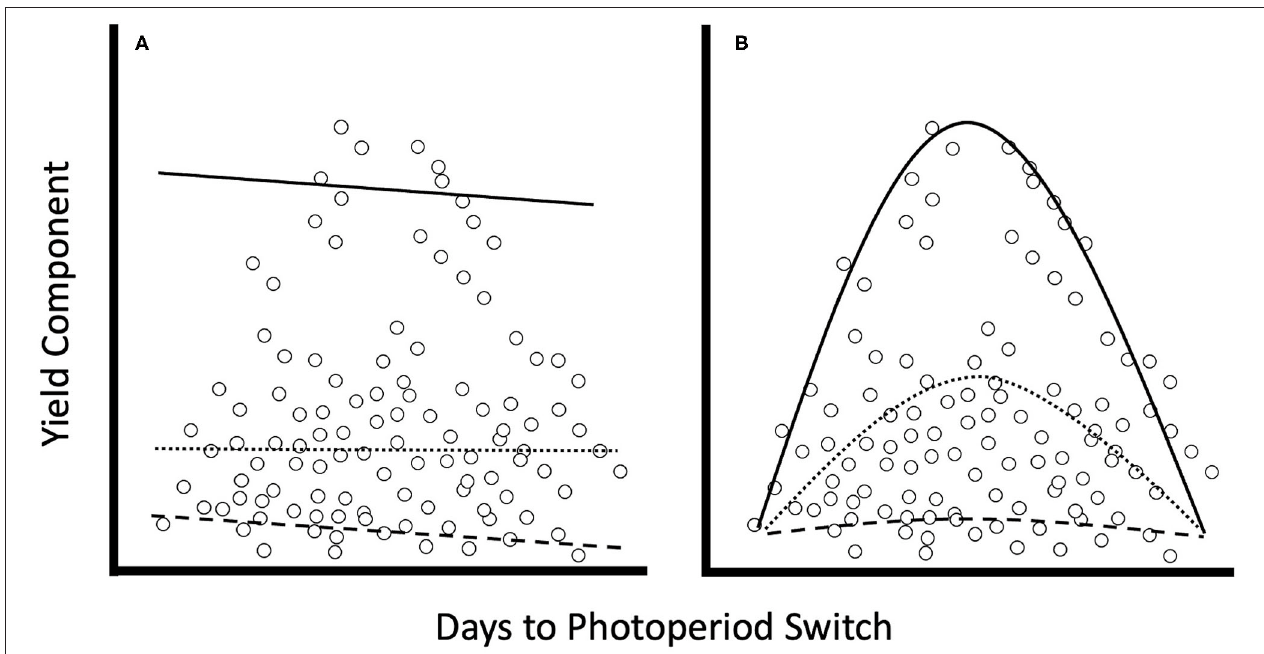
FIGURE 1 | Graphs comparing trendlines for linear vs. quadratic quantile regression (After this figure in Mills and Waite, 2009). When comparing yield from plants grown across a wide range of environments, we cannot expect that plants will exhibit the same average outcomes under different environmental conditions. Thus, quantile regression allows us to model the worst performance (5th quantile = dashed line), average performance (50th quantile = dotted line), and the best performance (95th quantile = solid line), given a particular environmental state for both (A) linear and (B) quadratic